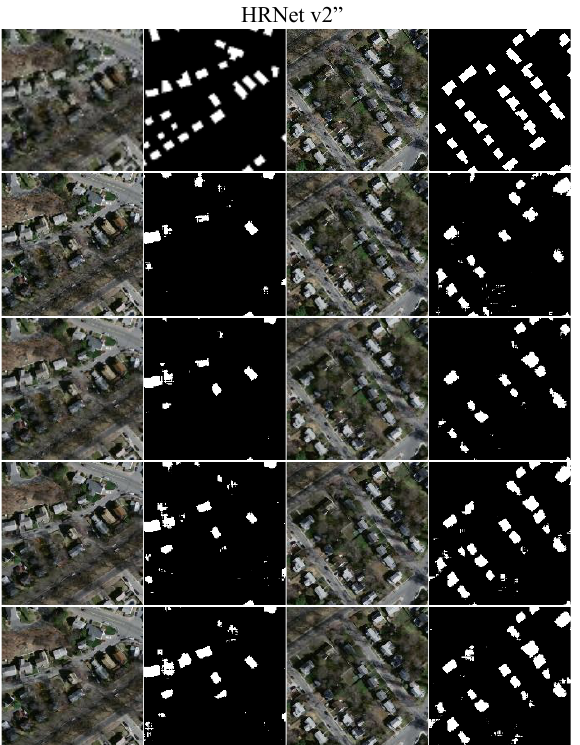
Fig. 4. Examples of the extraction results using “RCAN-HRNet